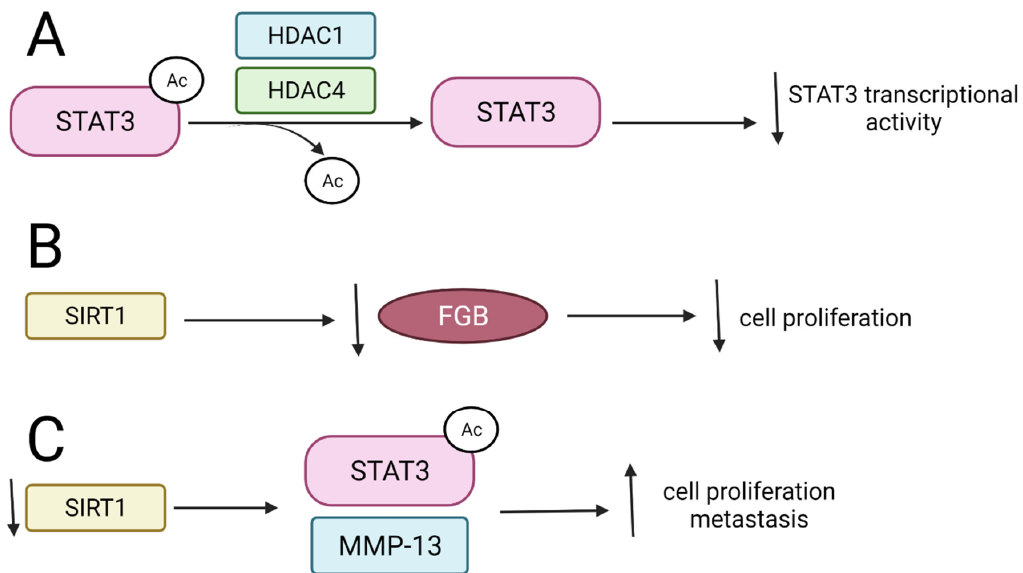
Figure 5. The influence of SIRTs and HDACs on STAT deacetylation and biological results of these modifications. ↑ — upregulation, ↓ —downregulation. ( A ) HDAC1 and HDAC4 deacetylate STAT3-Ac leading to decrease in STAT3 transcriptional activity; ( B ) SIRT1 represses FGB leading to inhibition of cell proliferation; ( C ) Downregulation of SIRT1 results in upregulation of STAT3-Ac and MMP-13 what enhances cell proliferation.STAT—signal transducers and activators of transcription; FGB—fibrinogen beta chain; MMP13-matrix metalloproteinase 13.